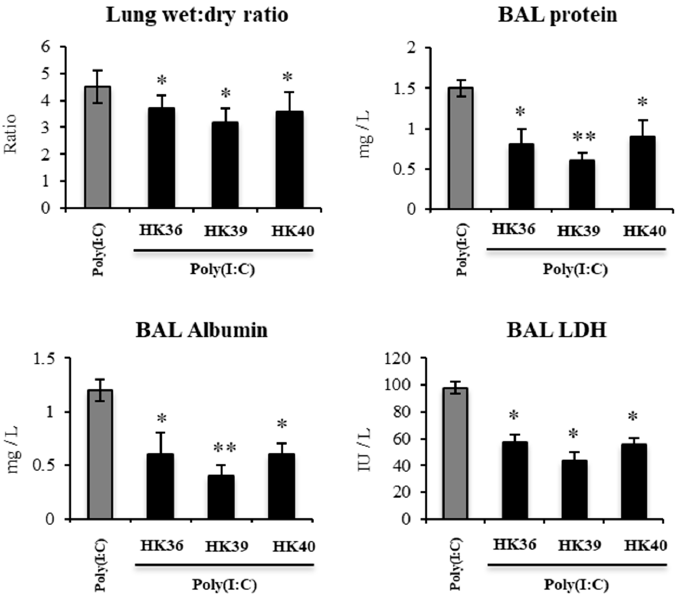
Figure 10. Effect of non-viable Lactobacillus gasseri strains on the lung tissue injury induced by the activation of Toll-like receptor 3 (TLR3). Infant mice were nasally primed with non-viable L. gasseri TMT36 (HK36), TMT39 (HK39), or TMT40 (HK40) during two consecutive days and challenged with three once-daily doses of poly(I:C). Non-lactobacilli treated mice challenged with poly(I:C) were used as controls. Lung wet: dry ratio, broncho-alveolar lavages (BAL) concentrations of albumin and proteins, and lactate dehydrogenase (LDH) activity were evaluated 2 days after the last poly(I:C) administration. The results represent data from three independent experiments. Significant differences were observed when compared to the control group * ( p < 0.05), ** ( p <